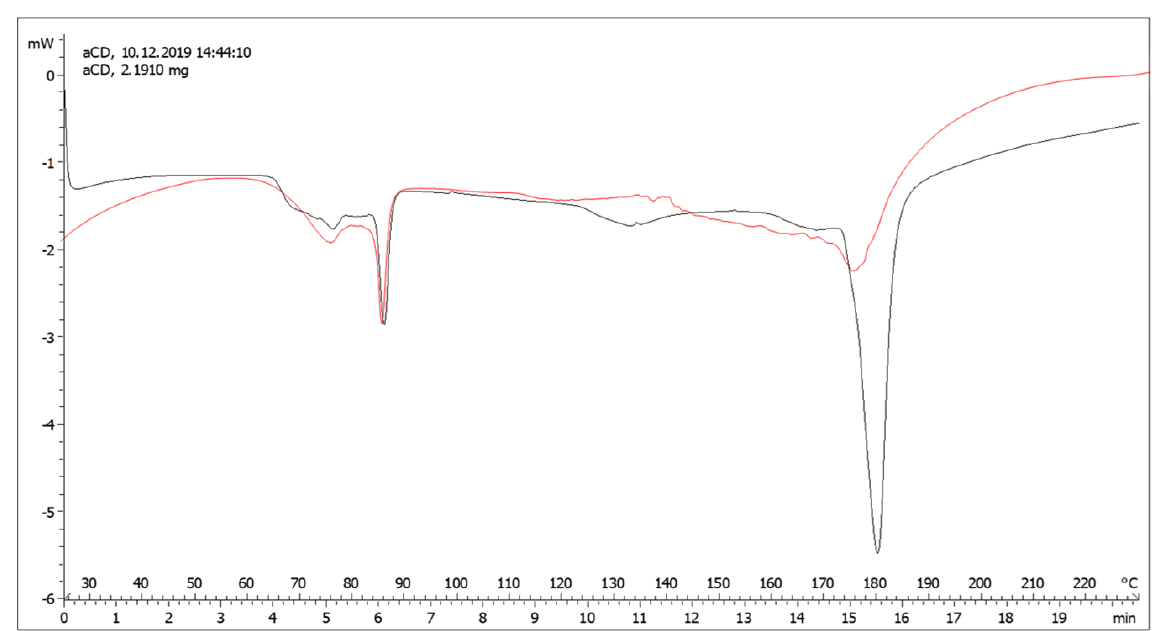
Figure 3. EVOO: α CD inclusion complexes at different ratios: ( a ) EVOO: α CD at 1:1.8 weight w : w ; ( b ) 1:2.6 w : w , and ( c ) 1:3.4 w:w .